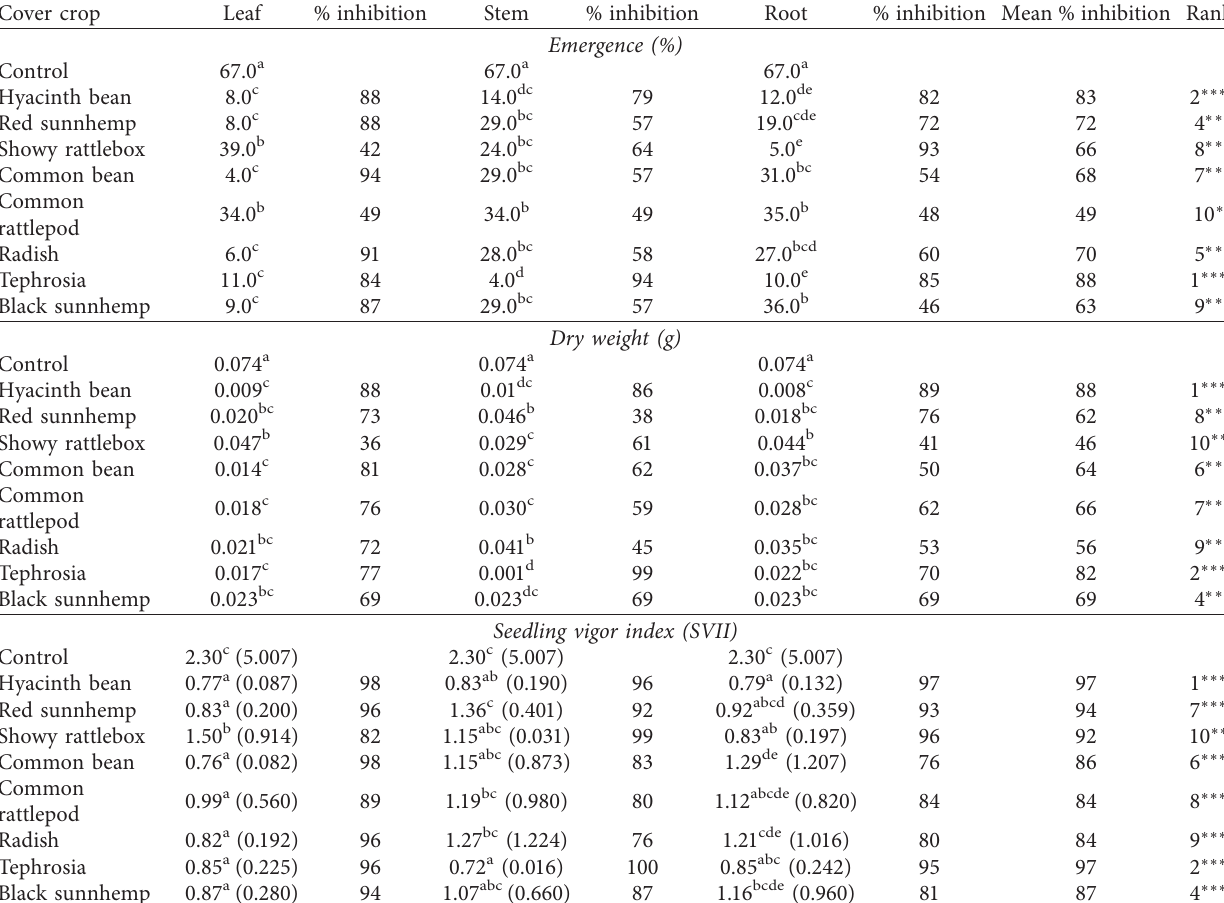
Table 7: Effect of soil incorporated residues of different plant parts of cover crops on emergence (%), dry weight, and seedling vigor index (SVII) of